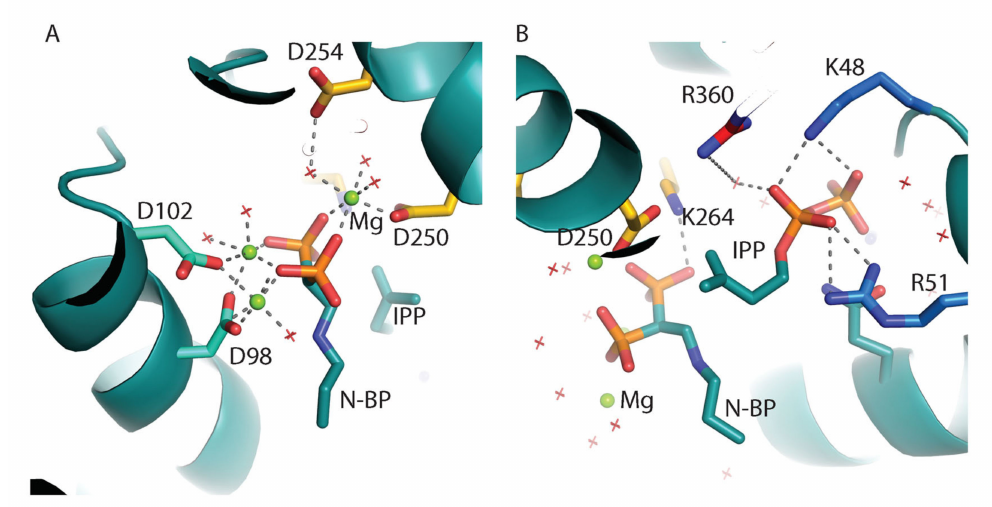
Figure 5. Active site of Trypanosoma cruzi farnesyl pyrophosphate synthase (FPPS) in complex with a N-BP ([2-(n-propylamino)ethane-1,1-diyl] bisphosphonic acid), Mg 2 + , and isopentenyl pyrophosphate (IPP) (PDB ID 4DXJ). ( A ) Coordination of Mg 2 + is shown with grey dashed lines. Residues of the aspartate rich motifs are shown as sticks. Water molecules are shown as red crossmarks. ( B ) IPP is at hydrogen bonding distance of K48, R51, and